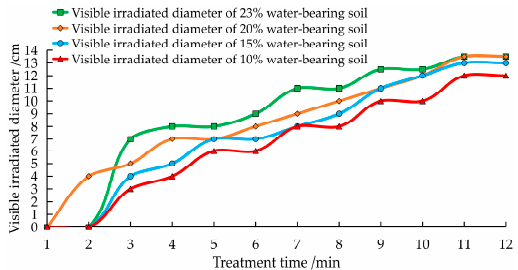
Figure 9. Diameter of circular area on the surface of loess irradiated by microwaves.